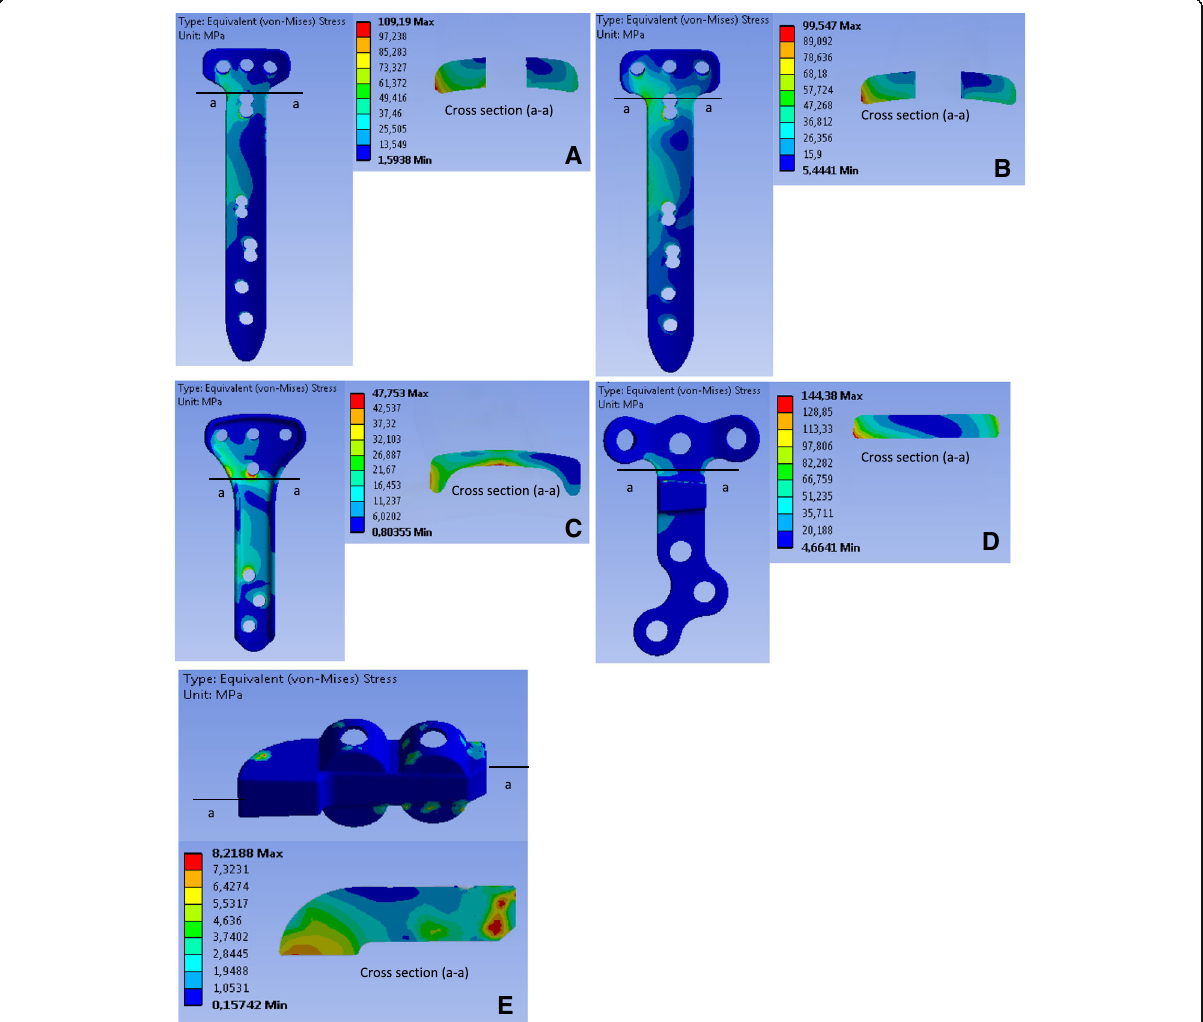
Fig. 6 Equivalent stress (von-Mises) in the implants in position 1: The letters a, b, c, d and e indicate the TomoFix sm, the TomoFix std., the PEEK Power, the Contour Lock and the iBalance